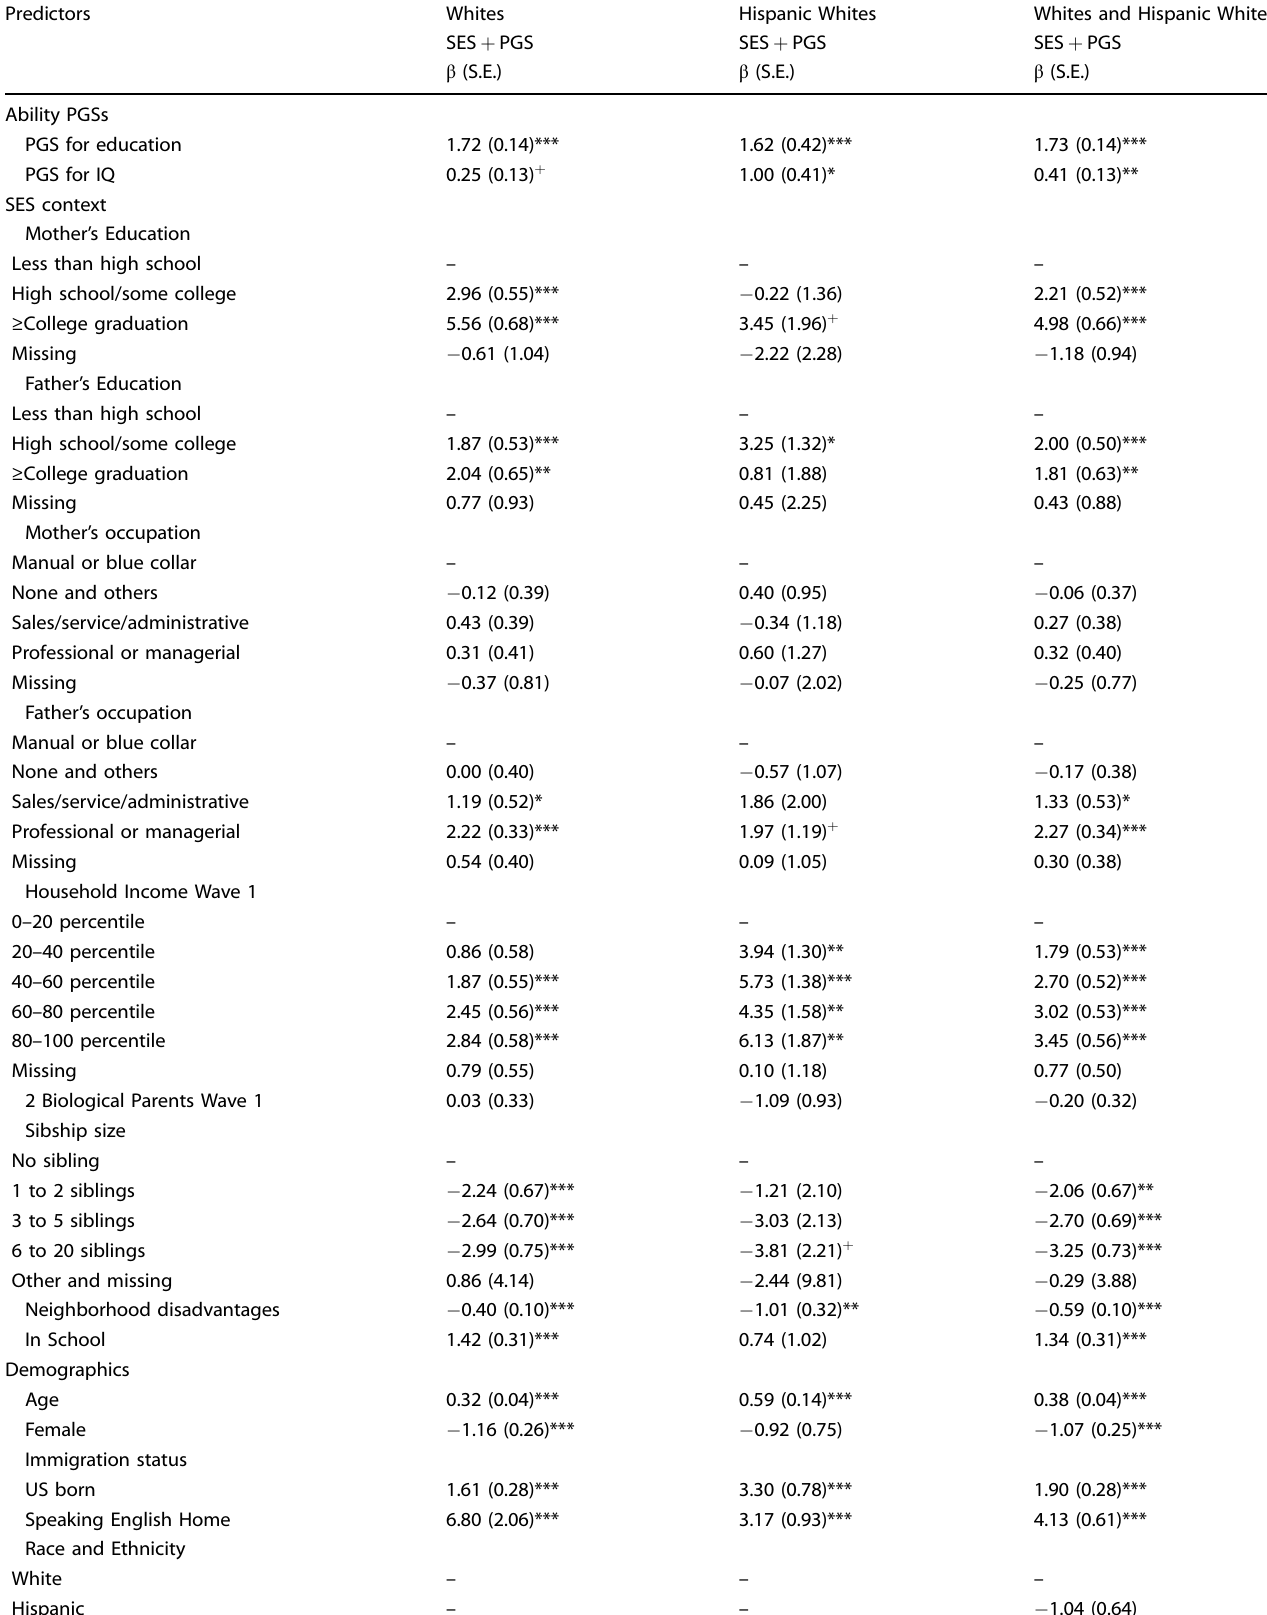
Table 4. Multilevel models of Wave-1 and 3 verbal ability showing coef fi cients (standard errors) of SES context and ability-related